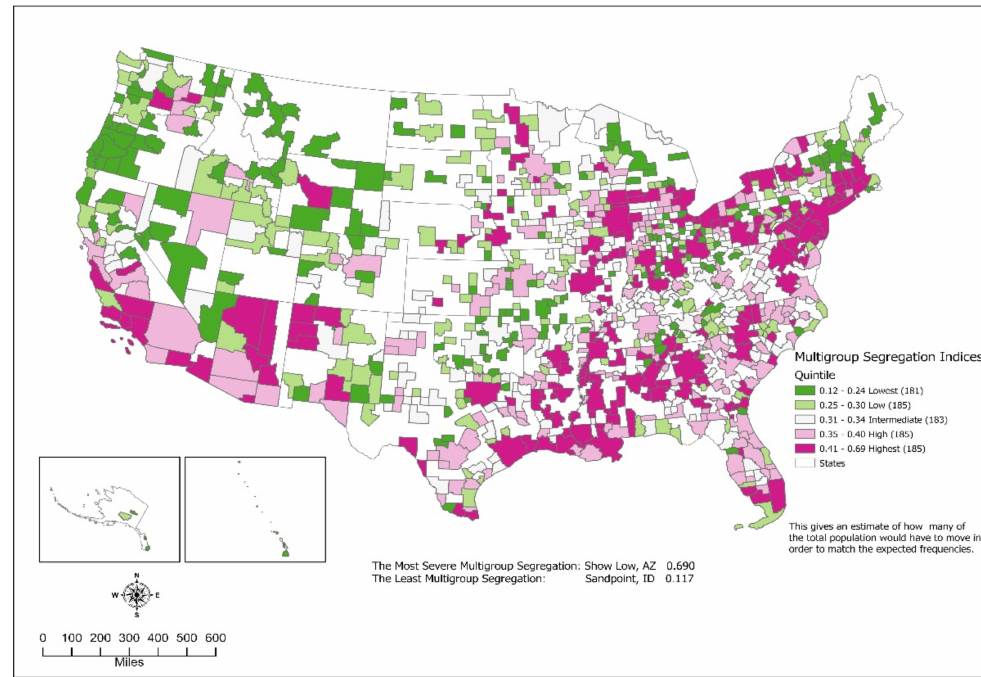
Figure 12. Multigroup Dissimilarity Indices, Metro/Micro Areas 2020.